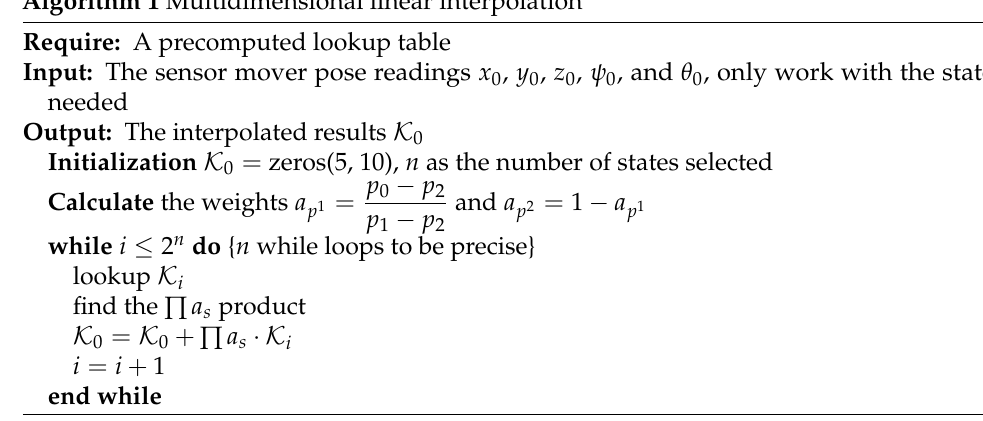
Algorithm 1 Multidimensional linear